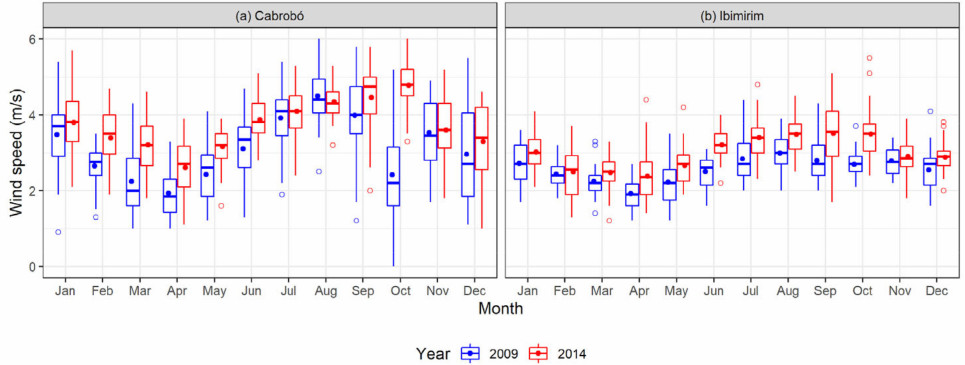
Figure 5. Monthly boxplots of hourly wind speed data in the Cabrob ó and Ibimirim sites in 2009 (wet year) and 2014 (dry